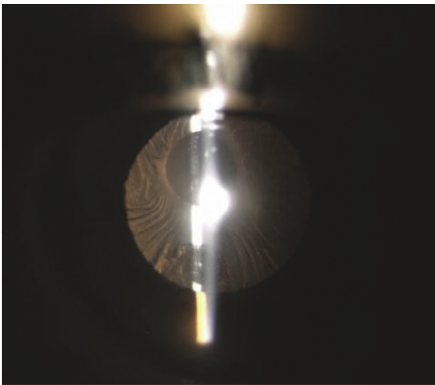
Figure 1: Slit lamp exam showing the presence of thick anterior capsule phimosis, involving visual axis.